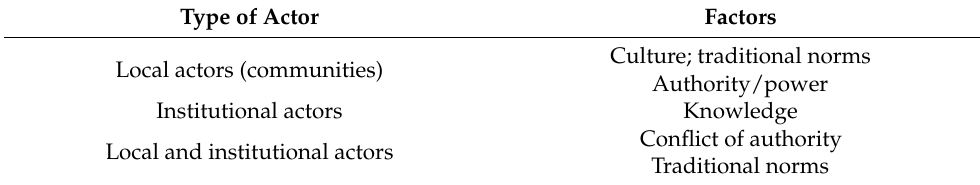
Culture; traditional norms Authority/power Conflict of authority Traditional norms